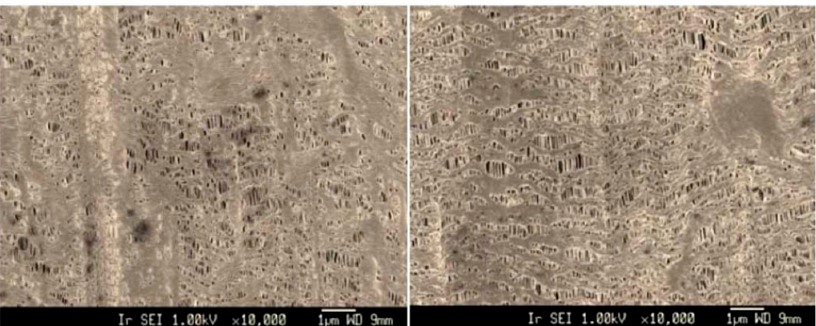
Figure 12. FE-SEM micrographs of HDPE microporous membranes as a function of annealing temperature: ( left ) 95 °C and ( right ) 125 °C, adapted from [99] .